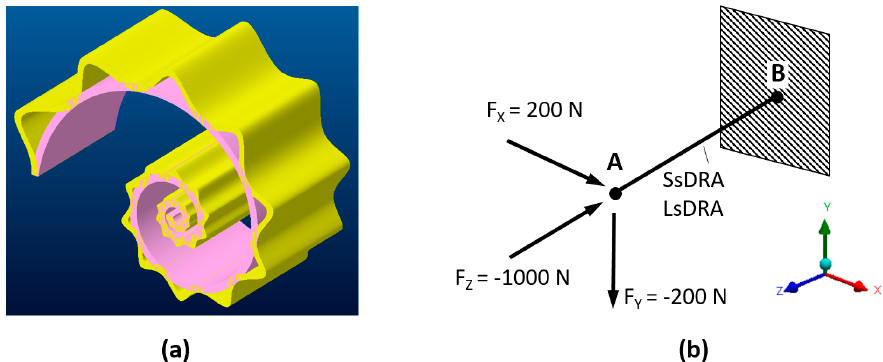
Figure A3. ( a ) Overlapping of equivalent SsDRA and LsDRA models; ( b ) cantilever configuration with a fixed support in B and loads applied in A used for FEM analysis.